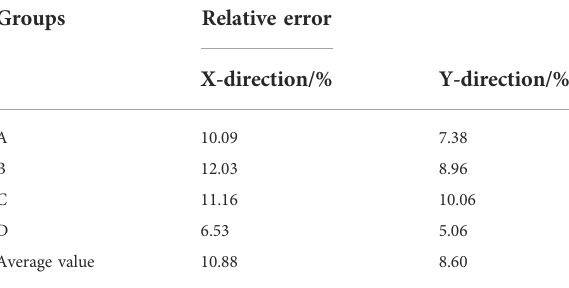
TABLE 4 Relative error analysis